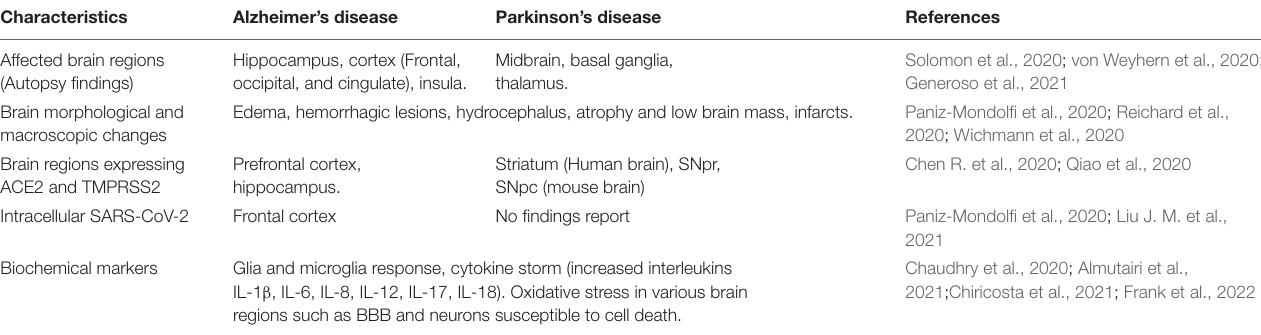
TABLE 1 | CNS damage by SARS-CoV-2 suggesting susceptibility to Parkinson’s and Alzheimer’s disease.